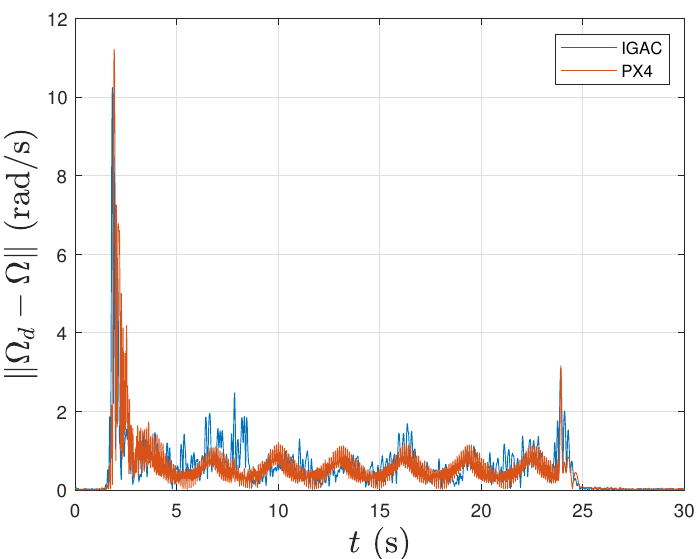
Figure 18. Norm of angular velocity error in SITL simulation.